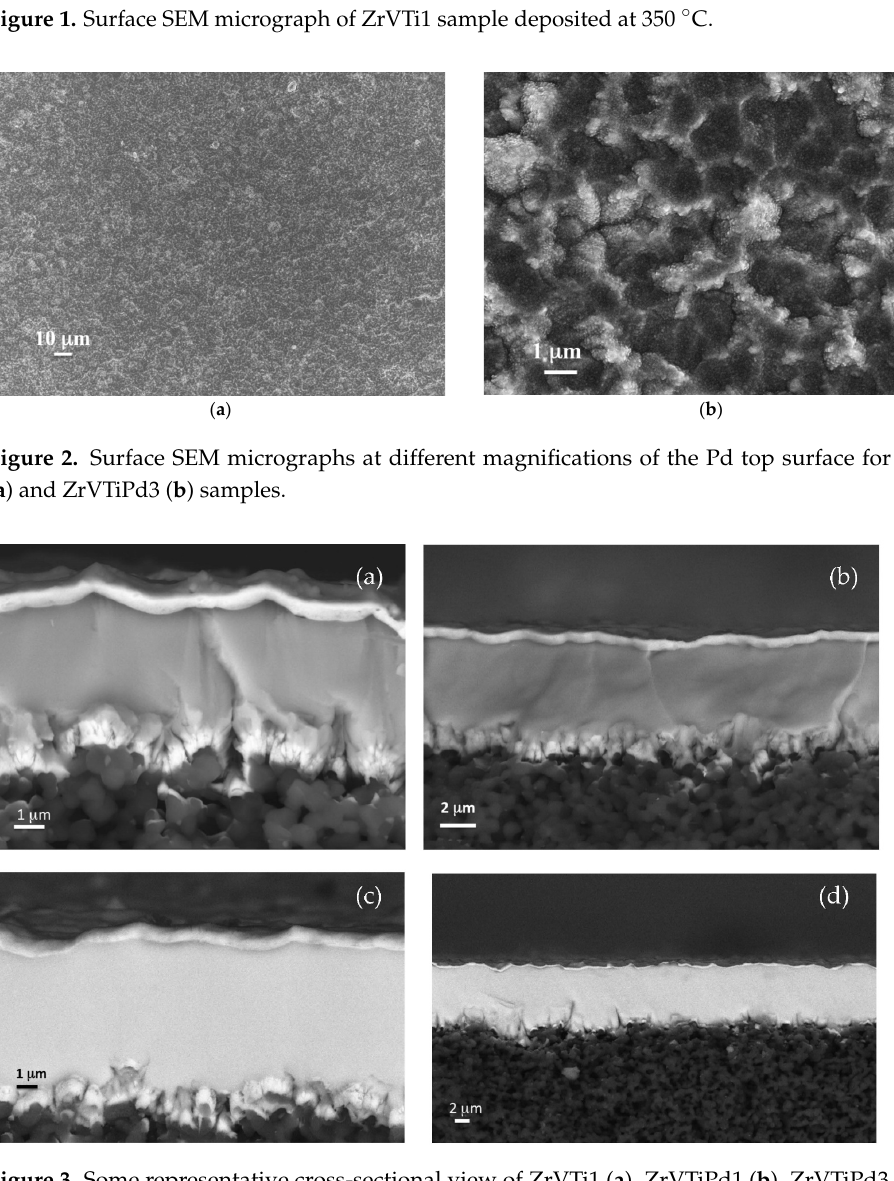
Figure 3. Some representative cross ‐ sectional view of ZrVTi1 ( a ), ZrVTiPd1 ( b ), ZrVTiPd3 ( c ), and ZrVTiPd5 ( d ) membranes, taken under backscattered electron mode. XRD analyses of only the alloy without the thin Pd film on top were not performed due to oxide presence. Figure 4 shows two typical XRD profiles collected for the ZrVTiPd4 sample prior to hydrogen permeation tests and for ZrVTiPd6 after the tests. Rietveld re ‐ finements were performed by taking into account and modeling the systems as multi ‐ layers composed of porous α‐ Al 2 O 3 and supporting the three thin layers made as Pd/Zr x V y Ti z Pd w /Pd. The fit of the ZrVTiPd4 sample had a weighted profile R ‐ factor (Rwp) of 21.0% and a goodness ‐ of ‐ fit ( χ 2 ) value of 1.18, while the ZrVTiPd6 sample had Rwp = 21.8% and χ 2 = 1.17. Both profiles showed the small sharp peaks of the highly crystalline, porous α‐ Al 2 O 3 (trigonal, space group R ‐ 3c), showing exactly the same cell parameters (a = 4.763 ± 0.001 Å, c = 13.007 ± 0.001 Å) in all samples. The protective films contributed with the most intense (111) peak at about 40.05° for all samples, corresponding to pure Pd (cu ‐ bic, space group Fm ‐ 3m) with the same cell parameters of 3.895 ± 0.001 Å. The ZrVTiPd4 sample showed small contributions of two Pd ‐ like phases with (111) peaks at 38.7° and 39.3°, probably arising from the solid solution of atoms at the interface, especially due to Ti and Zr that have larger atomic radii than Pd. The intermediate alloy film exhibited as a quasi ‐ amorphous phase in both cases and generally in all considered membranes, with a broad band between 35° and 45°. The contribution was modeled with a Pd ‐ like phase in which cell parameter was influenced by the presence of Zr, Ti, and V in a solid solution. The cell parameter was a = 4.08 Å for the ZrVTiPd4 sample and a = 3.89 Å for ZrVTiPd6. The values were consistent with the considerably higher concentration of Zr in the ZrVTiPd4 sample, which had a larger atomic radius than Ti, V, and Pd. The presence of the quasi ‐ amorphous alloy in the as ‐ deposited films, which was also confirmed in the spectra of films treated at 350 °C and in membranes tested in hydrogen up to 450 °C,